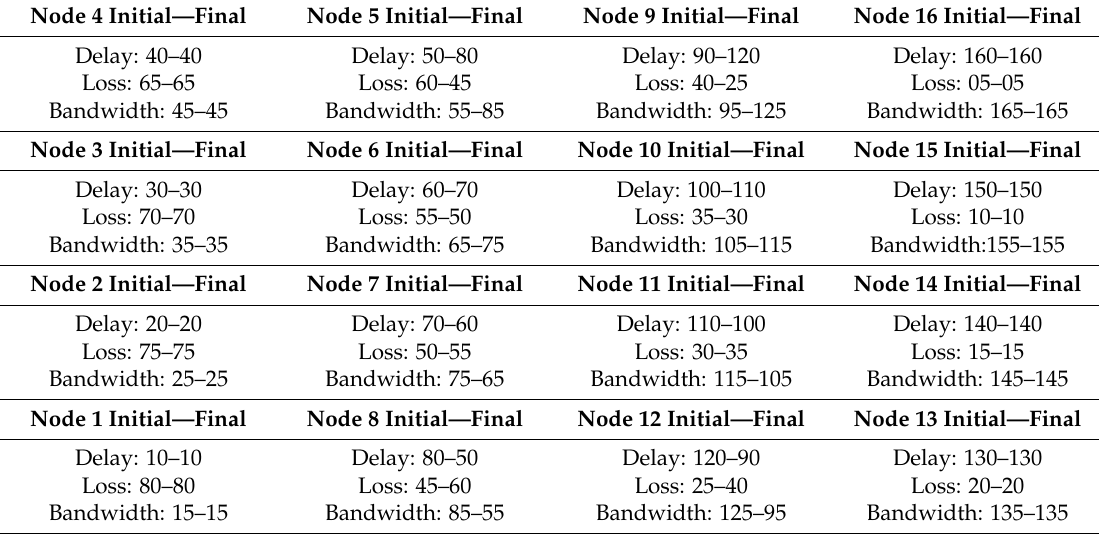
Table 1. QoS Values (4 × 4